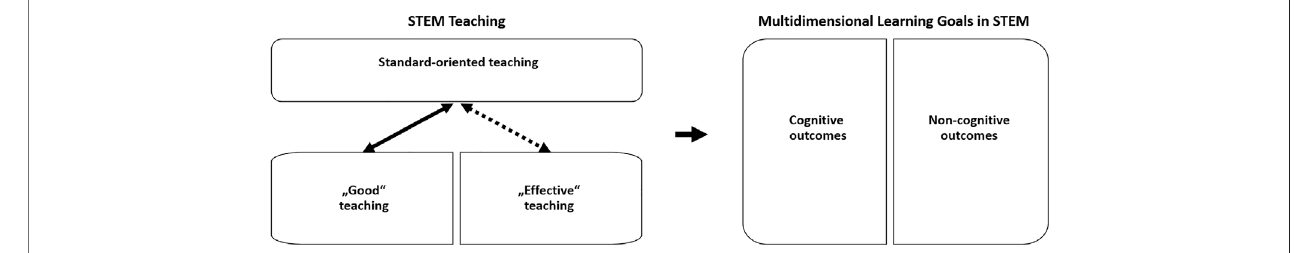
FIGURE 1 | The relationship between Standard-oriented teaching and Multidimensional Goals in STEM